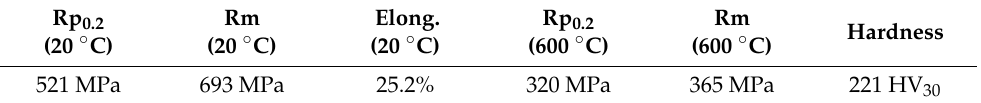
Table 2. Mechanical properties of the SA 355 P91 steel base material (by Vallourec company).